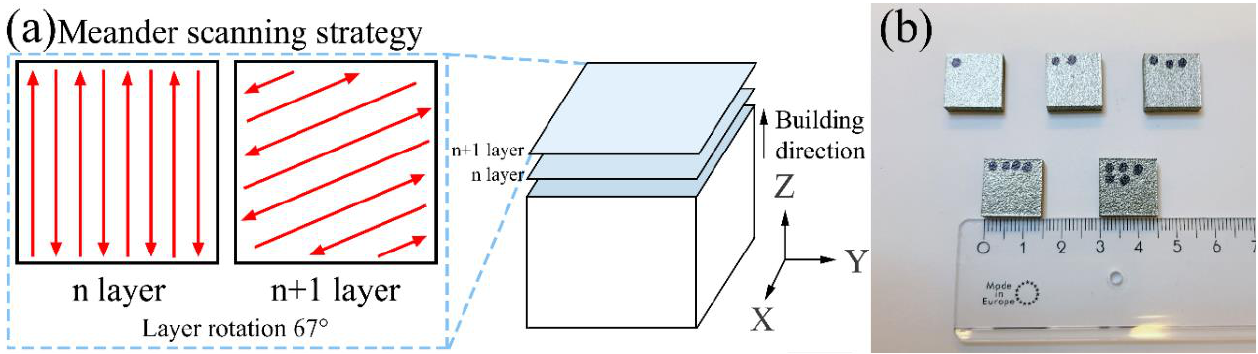
Figure 1. ( a ) Schematic illustration of LPBF scanning strategy, and ( b ) as-built AlCoCr 0.75 Cu 0.5 FeNi specimens applying different process